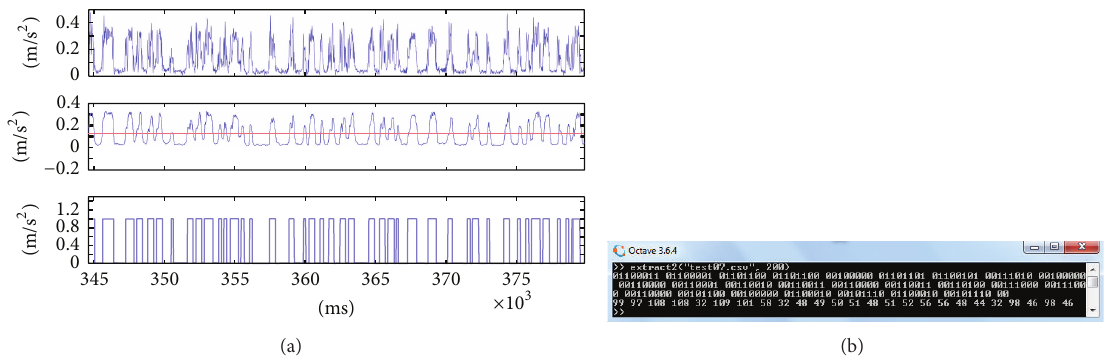
Figure 11: (a) The result of applying the extraction method on modulated acceleration signals from Samsung S3 Mini. (b) The decoded bits and equivalent 7-bit ASCII codes.